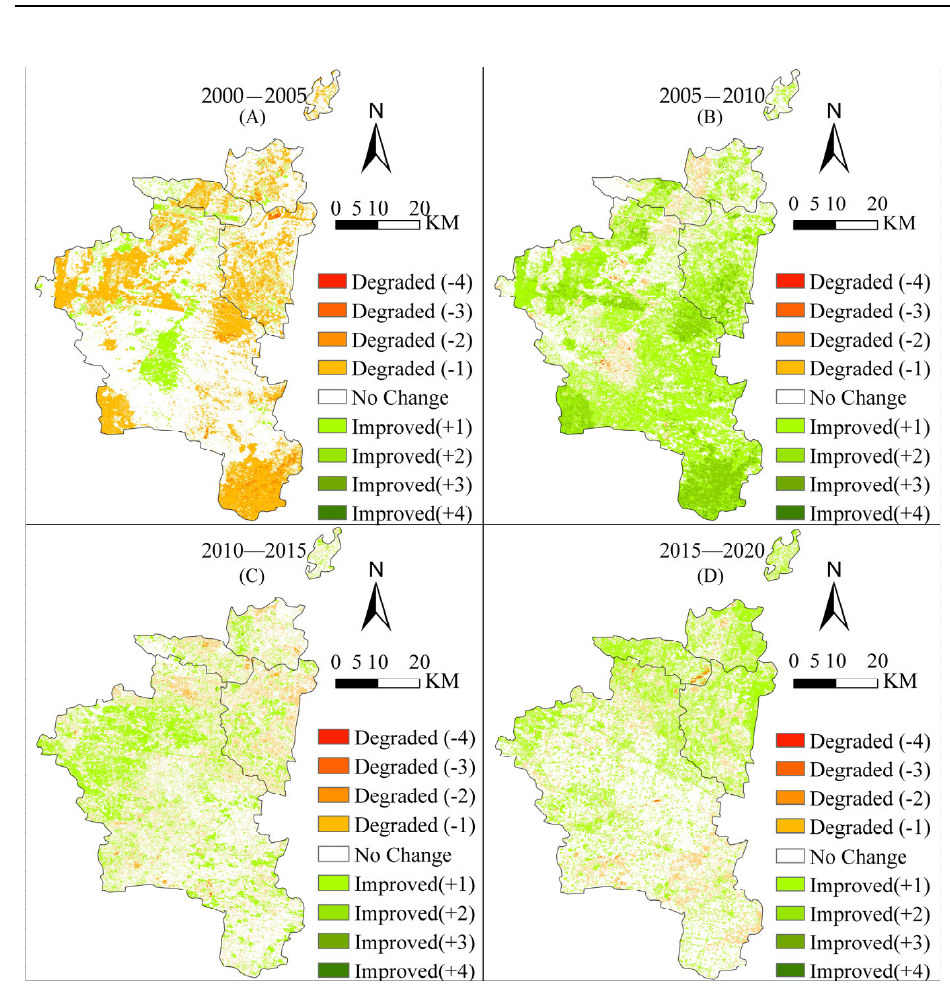
Figure 6. Spatiotemporal changes in the RSEI in Huaibei City during 2000–2020. The change level is +4, +3, +2, +1, − 1, − 2, − 3, and − 4. “+” represents the improvement of the ecological level, and “ − ” represents the deterioration of the ecological grade. “+4” means that the RSEI grade of a given area is represented by a pixel increased by four grades, e.g., from Poor to Excellent.The solid line in the figure is the administrative boundary line of Huaibei City.